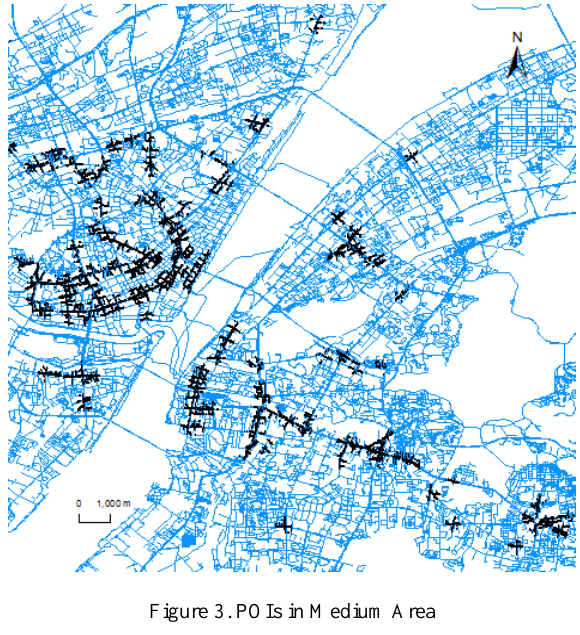
Figure 3. POIs in Medium Area